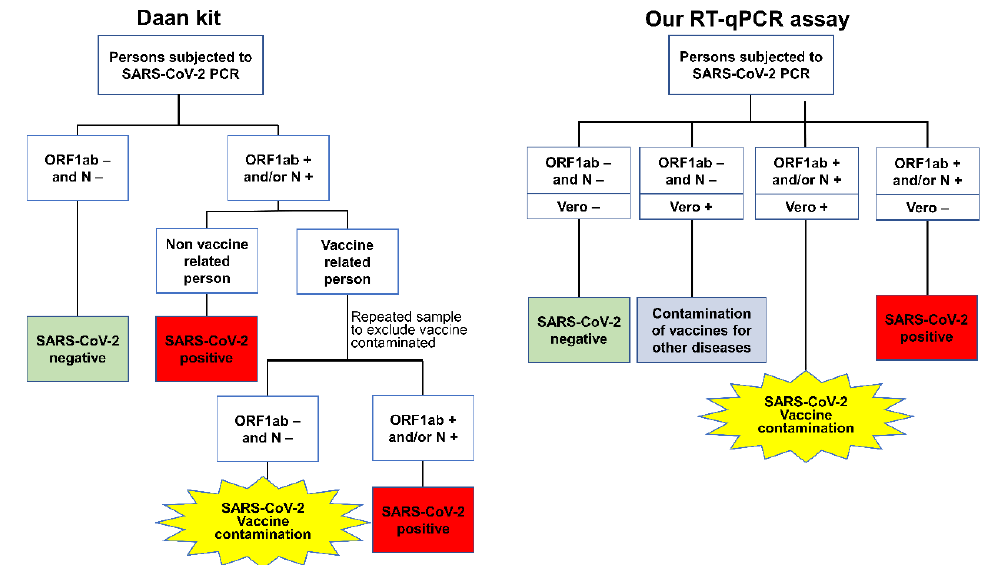
Figure 1. Flow chart of the interpretation of the clinical samples analysed by the Daan kit and our RT-qPCR assay. RT-qPCR